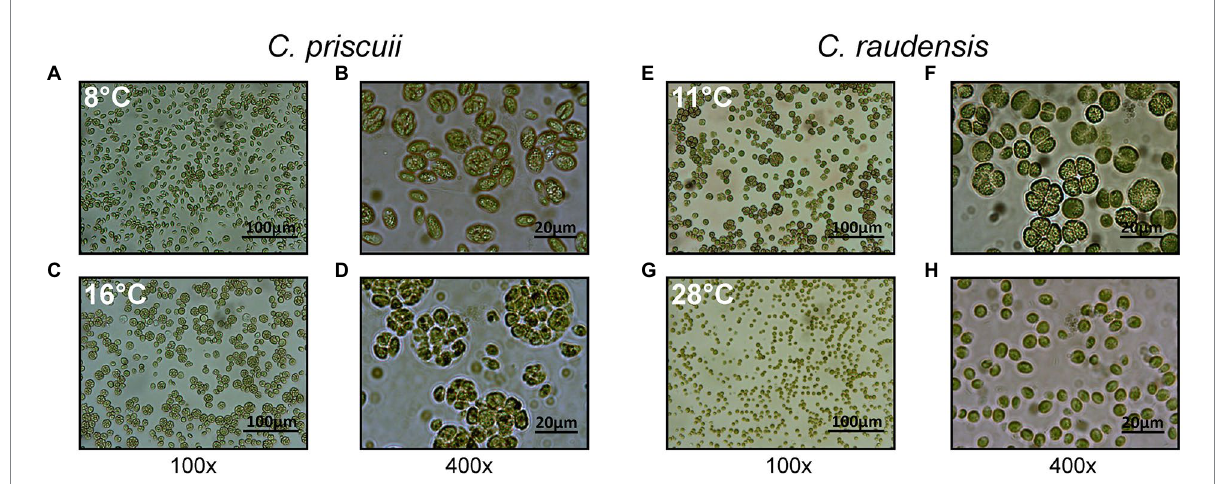
FIGURE 2 Light microscope images of both C. priscuii (A–D) and C. raudensis SAG 49.72 (E–H) cells grown under various steady-state temperatures, demonstrating the effects of growth temperature on cell morphology. The psychrophilic strain, C. priscuii exhibits a high ratio of palmelloids to single cells at its upper, suboptimal temperature of 16 ° C (C, D), compared to 8 ° C (A,B) , whereas the mesophilic C. raudensis SAG 49.72 strain shows this phenotype at its lower, suboptimal temperature of 11 ° C (E,F) , compared to 28 ° C (G,H)